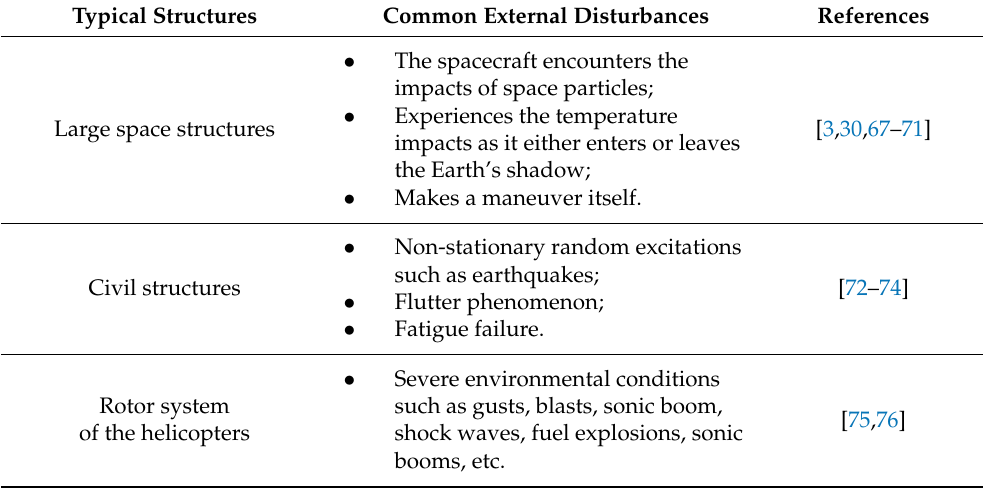
Table 2. External disturbances in several typical piezoelectric structures. Typical